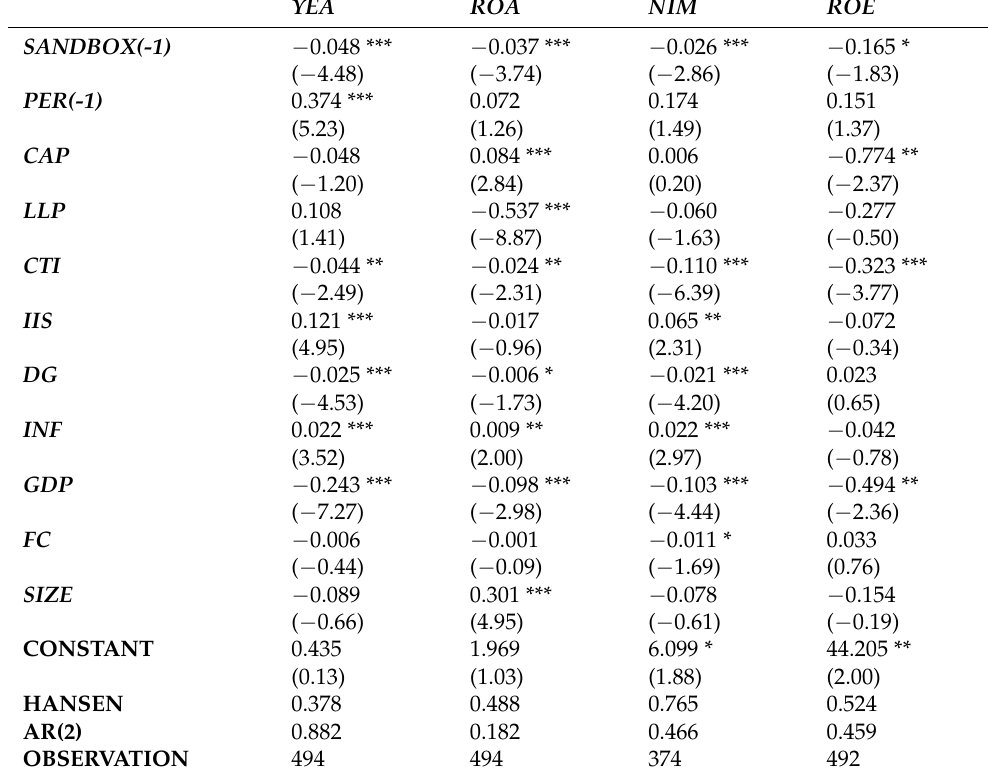
Table 6. Lag effect of regulatory Sandbox on bank